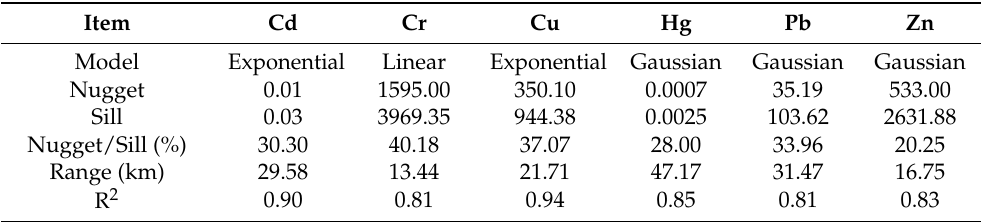
Table 6. Parameters of semi-variogram models for six heavy metals in